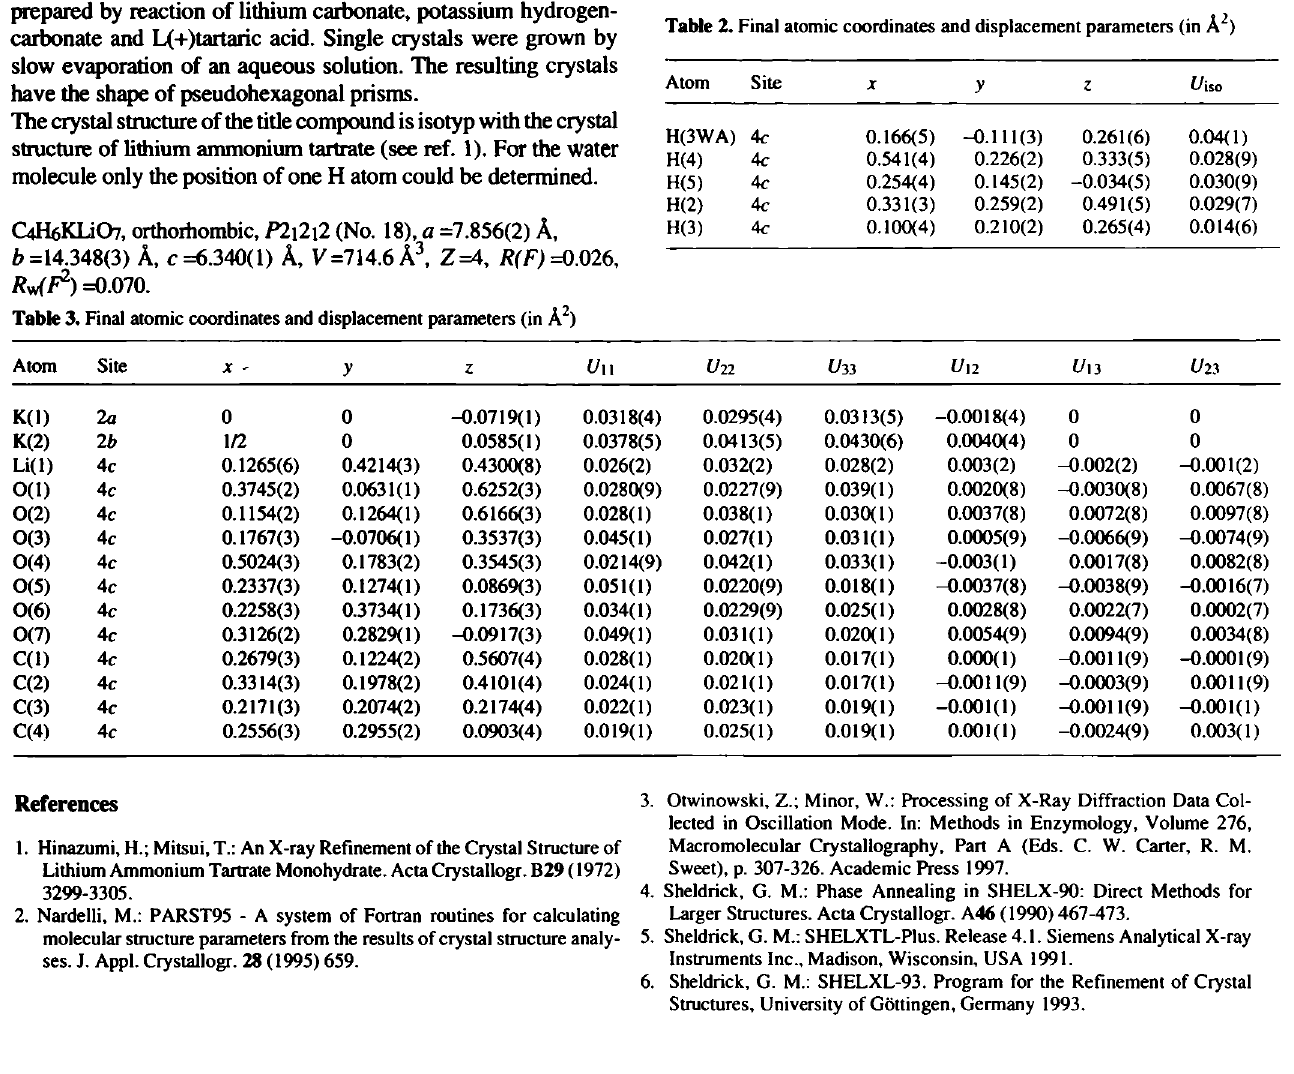
Table 2. Final atomic coordinates and displacement parameters (in